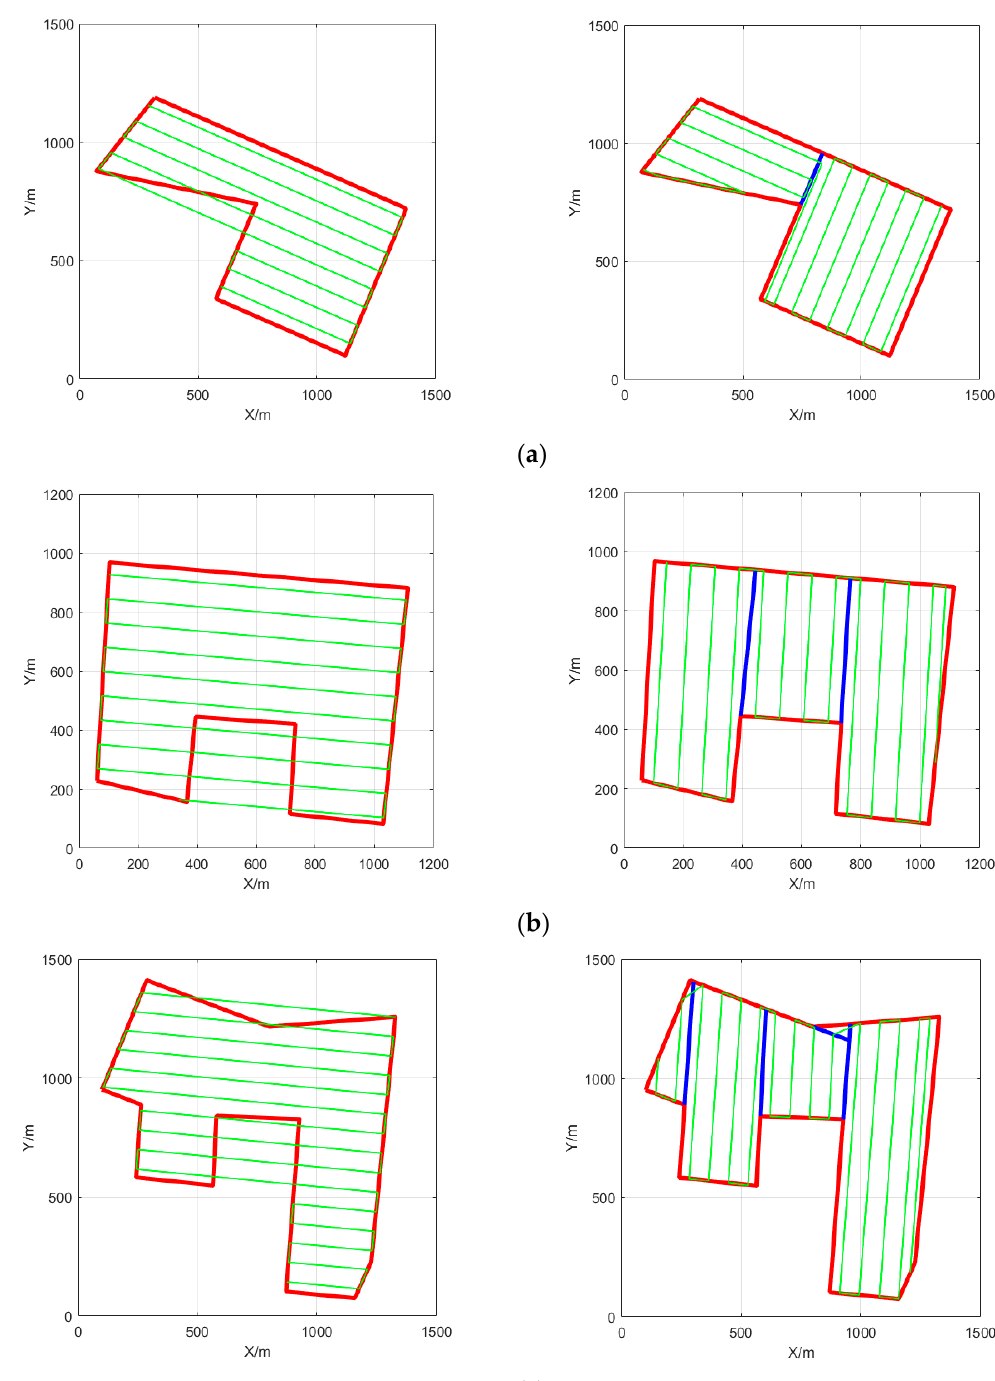
Figure 25. Five different shapes of detection areas. ( a ) Area A; ( b ) area B; ( c ) area C; ( d ) area D; ( e ) area E. The coverage paths of the five polygonal regions before and after ROD are shown in Figure 26. The left picture is the coverage path before ROD, while the right picture is the coverage path after ROD. The areas before and after the decomposition are covered by the BF path. It can be clearly seen that after ROD, the length of the non-working path in the coverage path is significantly reduced. Similarly, the total length of the coverage path after ROD is much smaller than the coverage path before ROD.